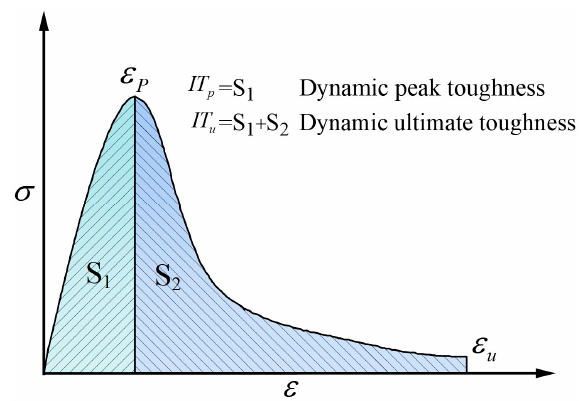
Figure 13. Schematic diagram of impact toughness calculation.